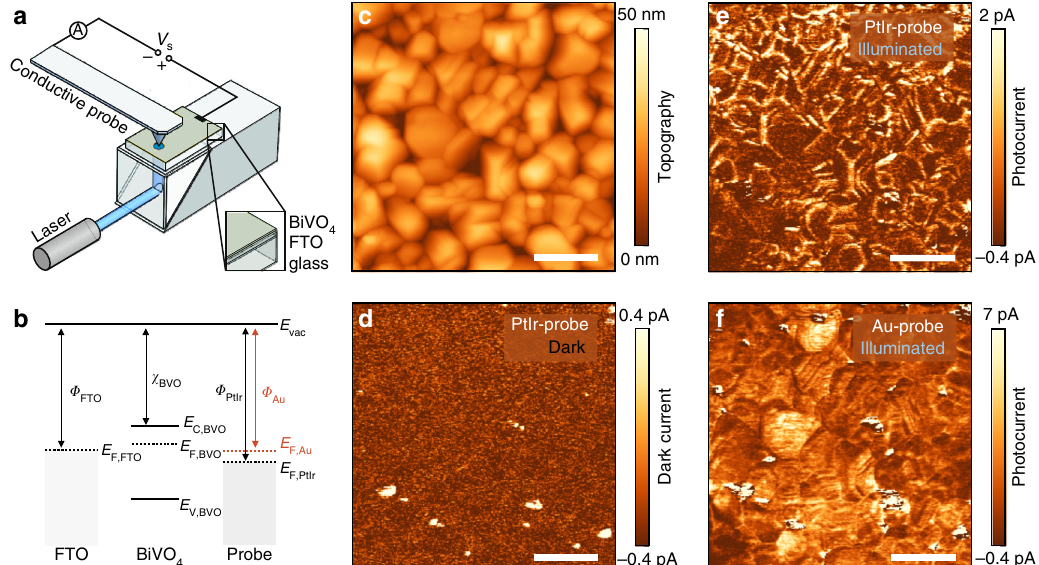
Fig. 1 Photoconductive AFM on BiVO 4 photoanodes. a Schematic illustration of the photoconductive atomic force microscope (pc-AFM) setup. The BiVO 4 fi lm is illuminated from the FTO side through the transparent glass substrate. The bias voltage ( V s ) is applied between the metal-coated probe and the transparent FTO back electrode. b Schematic illustrations of the relative energetic levels of FTO, BiVO 4 , and metal-coated probes. The solid lines indicate the vacuum level E vac , and the valence and the conduction band edge of BiVO 4 ( E C,BVO and E V,BVO ). The dashed lines show the Fermi level of FTO ( E F,FTO ), BiVO 4 ( E F,BVO ), and Au-coated and PtIr-coated probes ( E F,Au , and E F,PtIr ). The arrows indicate the work function of FTO ( Φ FTO ), the electron af fi nity of BiVO 4 ( χ BVO ), and the work function of Au-coated ( Φ Au ) and PtIr-coated probes ( Φ PtIr ). c Topography of BiVO 4 thin fi lm. d Dark current map is acquired with a PtIr-coated probe at an applied bias of 1.75 V. Corresponding photocurrent maps of the same area are acquired with a PtIr-coated probe ( e ) and an Au-coated probe ( f ) at an applied bias of 1.75 V and 1.45 V, respectively. The scale bar is 200